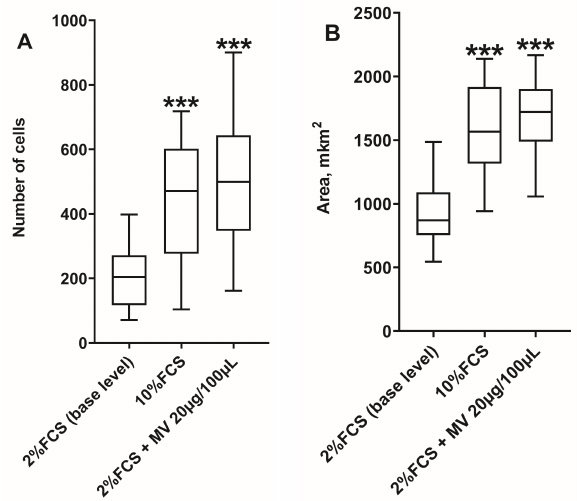
Figure 5. Migration of JEG-3 cells after cultivation in the presence of NK-92 cell MVs: ( A ) the number of cells migrated to the bottom surface of the polycarbonate inserts; ( B ) the area occupied by migrated cells on the bottom surface of the polycarbonate inserts (n = 3). 2% FCS (base level): base level of migration in culture medium with 2% FCS added; 10% FCS: migration in culture medium with 10% FCS added (positive control); 2%FCS+MV: migration in the presence of MVs of NK-92 cells at a concentration of 20 µ g/100 µ L for protein. Significant difference from baseline: *** p <